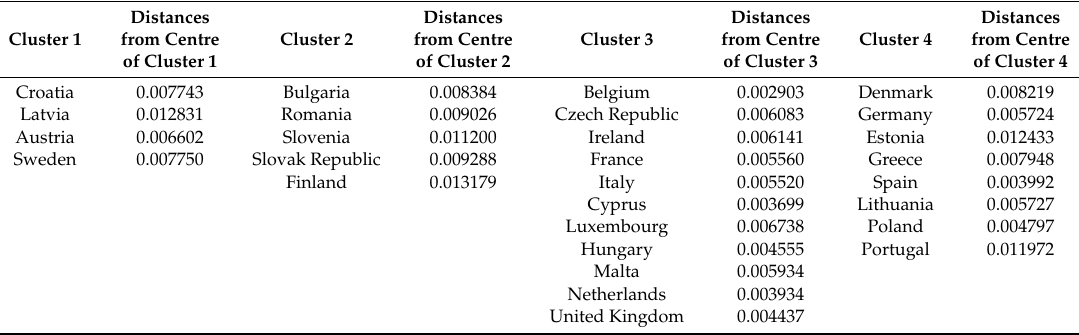
Table 16. Elements of clusters with distances from centers (own